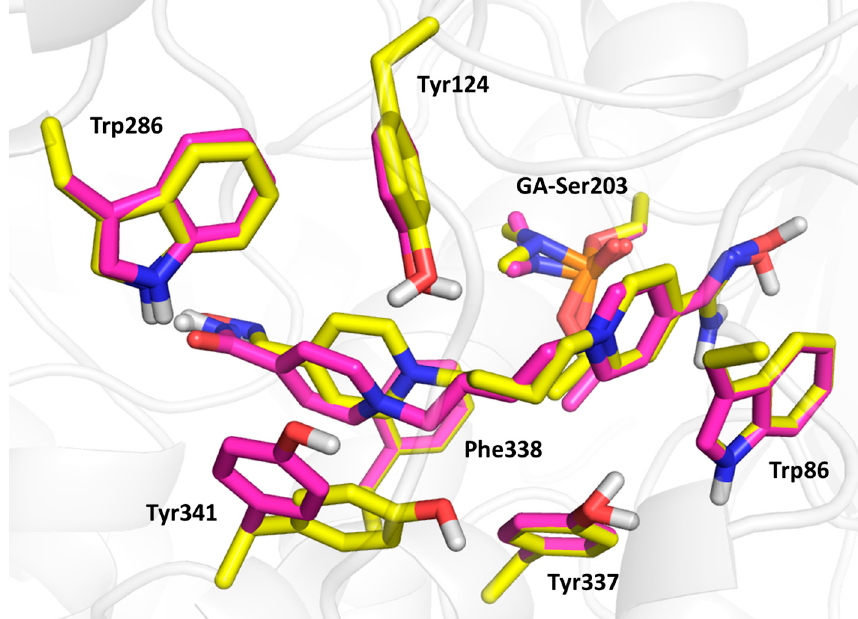
Figure 6. The molecular modelling results with selected flexible residues of compound 9 (in magenta) and compound 23 (in yellow).